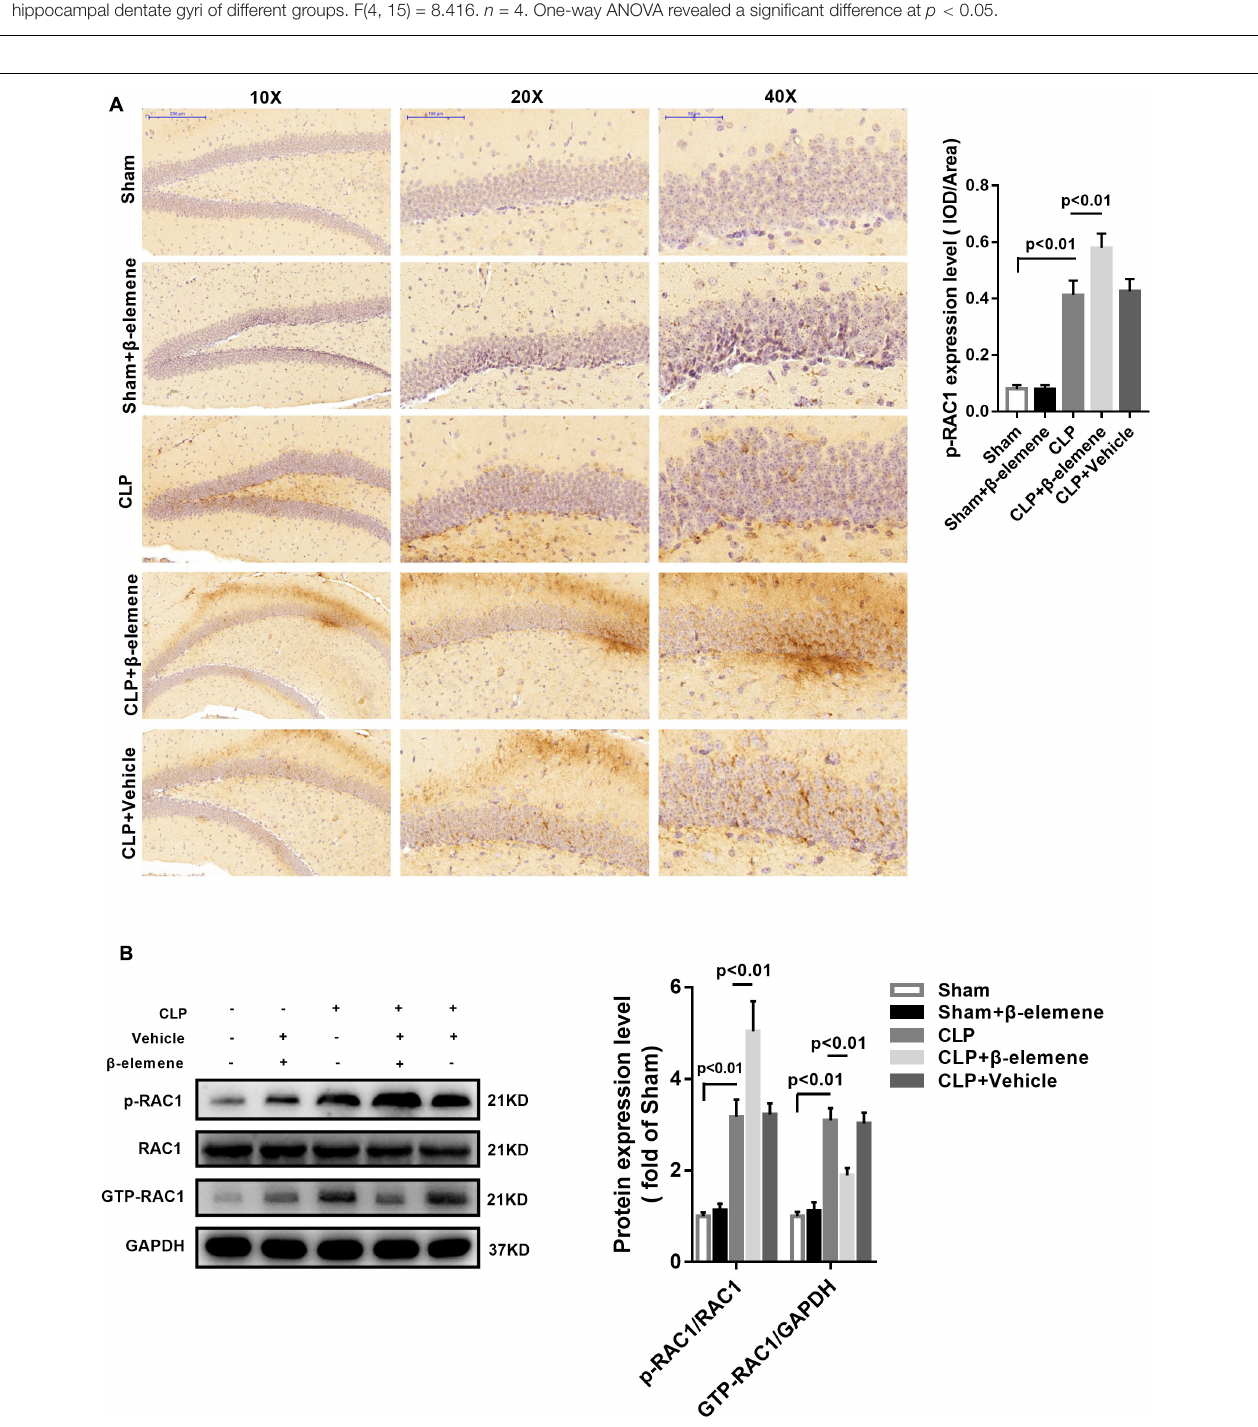
FIGURE 5 | β -Elemene reduced microglial activation in the hippocampus of CLP mice. (A) Immunofluorescence staining of IBA1 in the brains of different groups. Magnification: 200 × . (B) IBA1 numbers of positively stained hippocampal dentate gyri in different groups. F(4, 15) = 53.87. (C) Mean fluorescent pixels of IBA1 in the hippocampal dentate gyri of different groups. F(4, 15) = 8.416. n = 4. One-way ANOVA revealed a significant difference at p < 0.05.